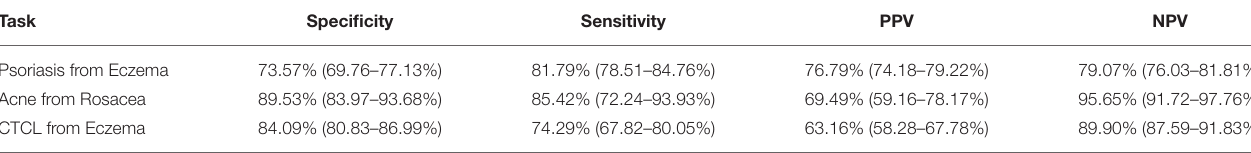
TABLE 2 | Results of best model; VGG-16P. Task